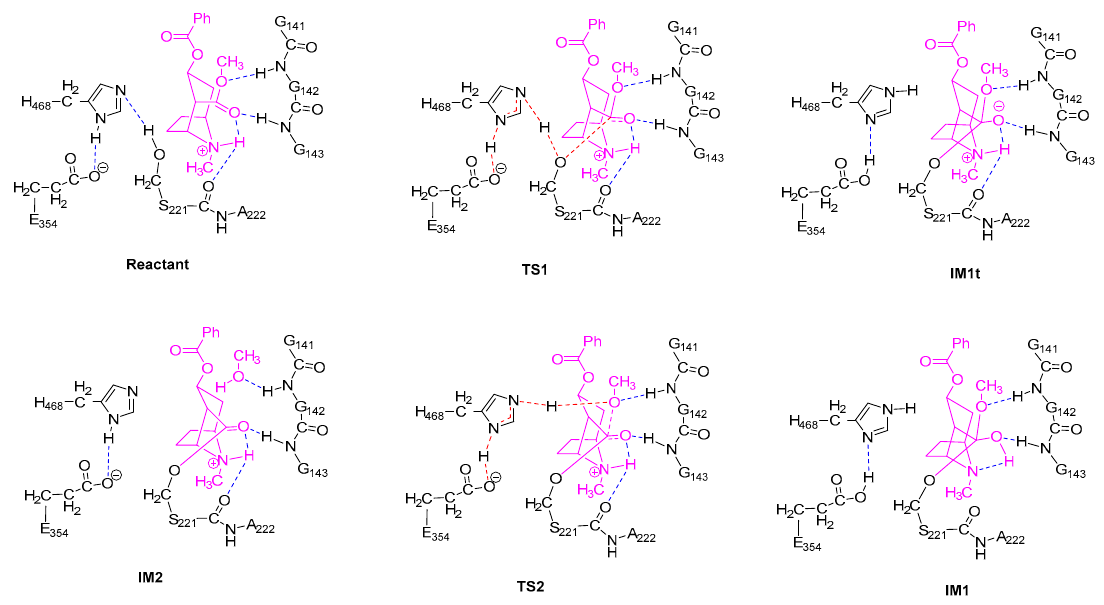
Figure 2. Transition states and intermediates in the acylation stage of hCES1. The ligands are shown in magenta. Non-polar residues which are far from the reaction center are not displayed. Blue dashed lines indicate common hydrogen bonds, and red/magenta dashed lines are bonds to be formed or broken.